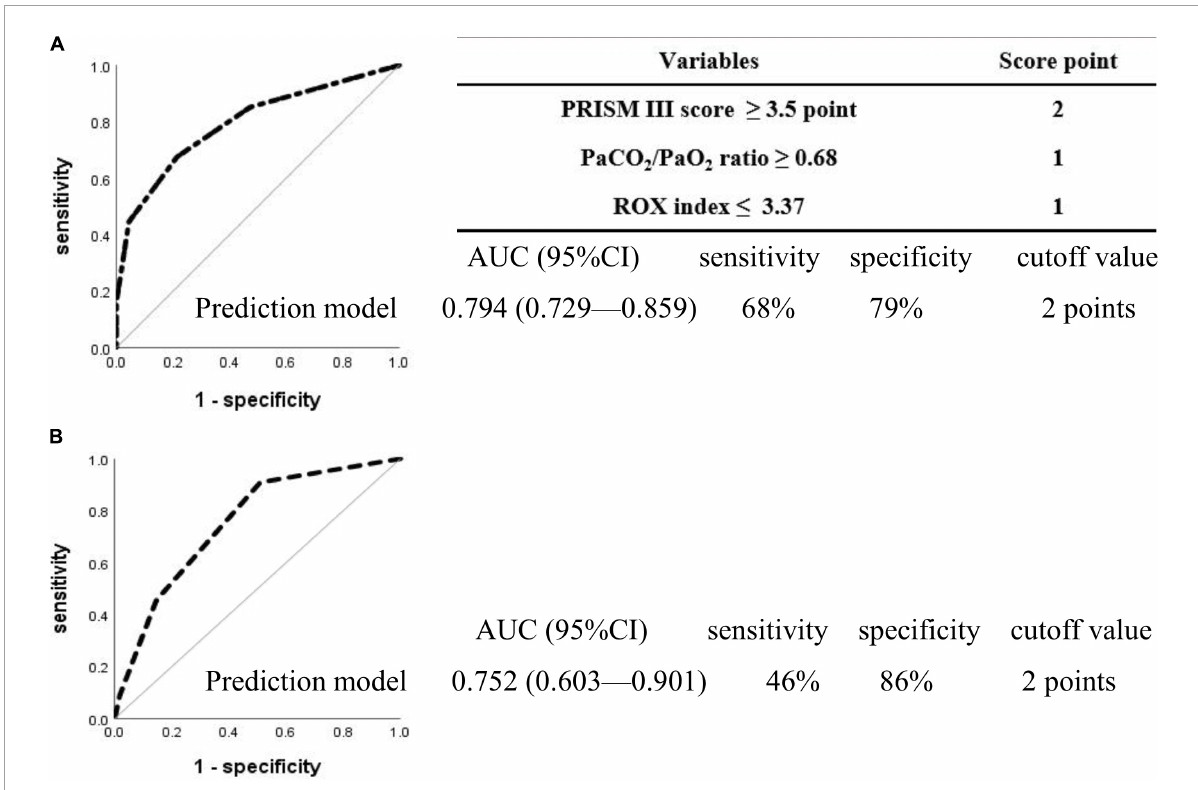
FIGURE2 Receiver operating characteristic curves for the prediction model in the patients with 24 h high-flow nasal cannula failure. Two hundred and eighty-two patients were included in the retrospective cohort (A) , 66 in the prospective observational cohort (B) , and no overlap was observed between the two cohorts. The discriminated cutoff point for the new scoring system to predict HFNC 24 h failure was ≥ 2 points, with an AUC of 0.794 (95% CI, 0.729–0.859, P < 0.001), sensitivity of 68%, and specificity of 79% in the retrospective cohort (A) , and with an AUC of 0.752 (95% CI, 0.603–0.901, P = 0.009), sensitivity of 46%, and specificity of 86% in prospective observational cohort (B) . PRISM, pediatric risk of mortality; PaCO 2 /PaO 2 , arterial partial pressure of carbon dioxide-to-arterial partial pressure of oxygen; ROX, ratio of percutaneous